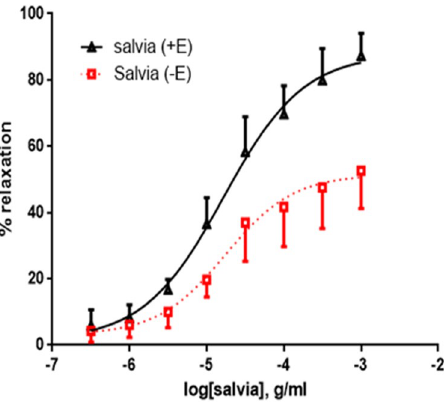
Figure 3. Role of endothelium in SF-induced relaxation. Cumulative dose-response curves for SF in isolated norepinephrine-precontracted rat aortic rings either with intact ( + E; triangles) or denuded endothelium ( − E; squares). n = 7; p < 0.01 for + E versus −